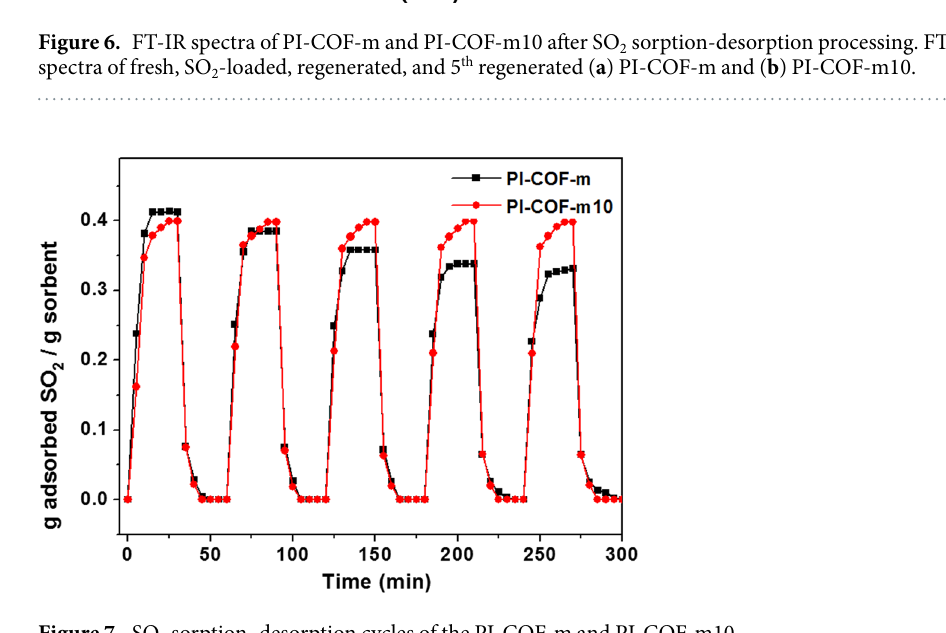
Figure 7. SO 2 sorption–desorption cycles of the PI-COF-m and